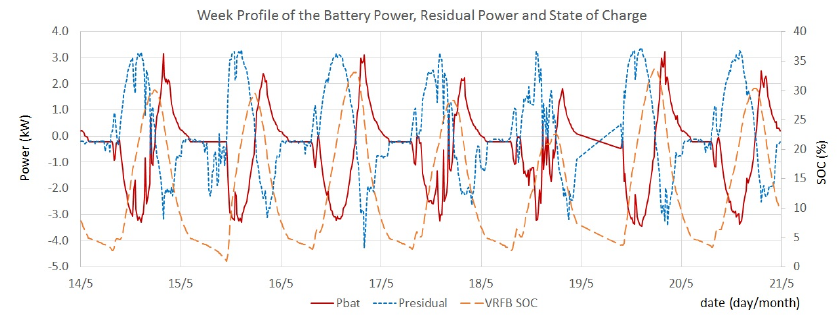
Figure 8. Variation of P bat , P residual , and state of charge (SOC), one week